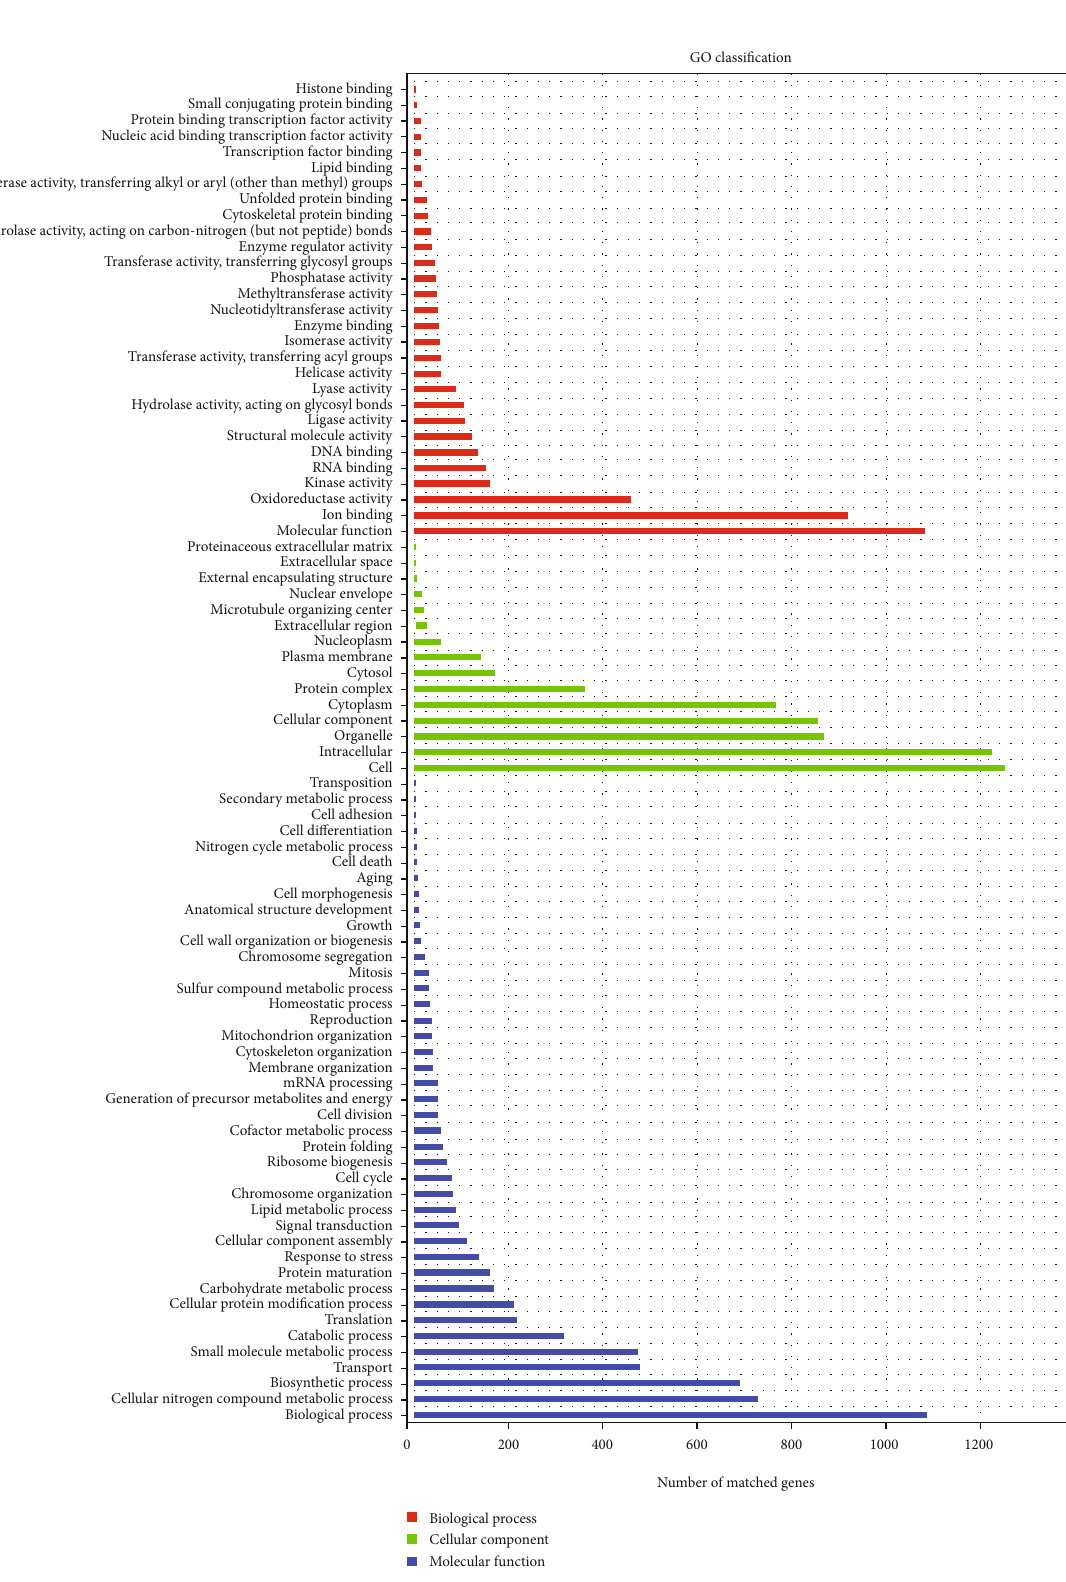
Figure 3: Gene Ontology (GO) functional annotation of genome. Blue, biological process; red, molecular function; green, cellular component. X -axis, number of matched genes; Y -axis (right), function